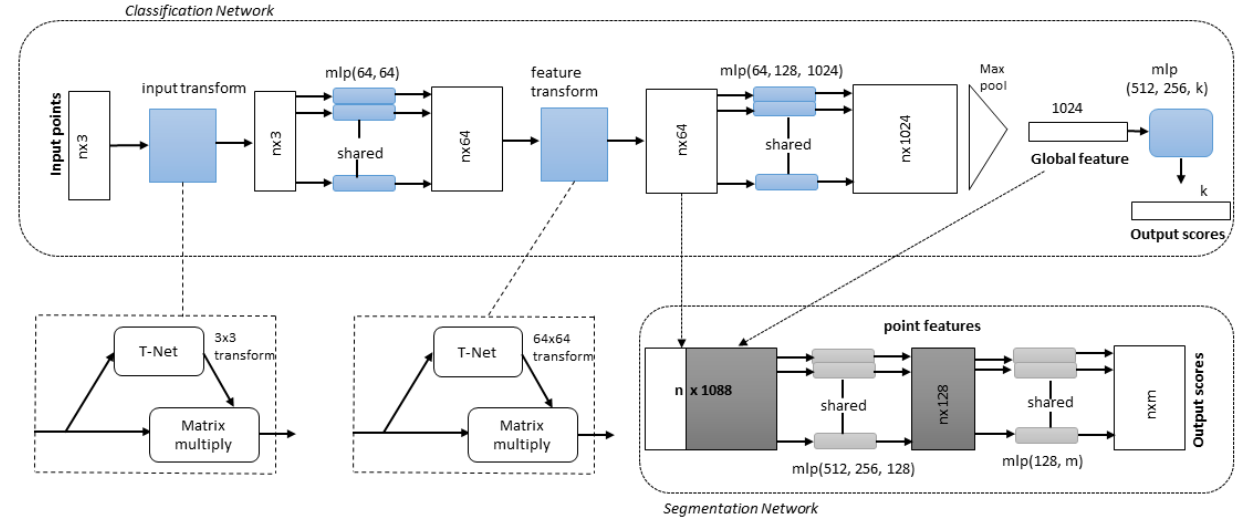
Figure 6. PointNet Architecture [12]. The classification network transforms n inputs into aggregate point features using feature transformation. It outputs k class classification scores. Then, the seg- mentation network concatenates the local and global features and generates per-point scores. The multilayer perceptrons (mlp) with layer size in brackets are also